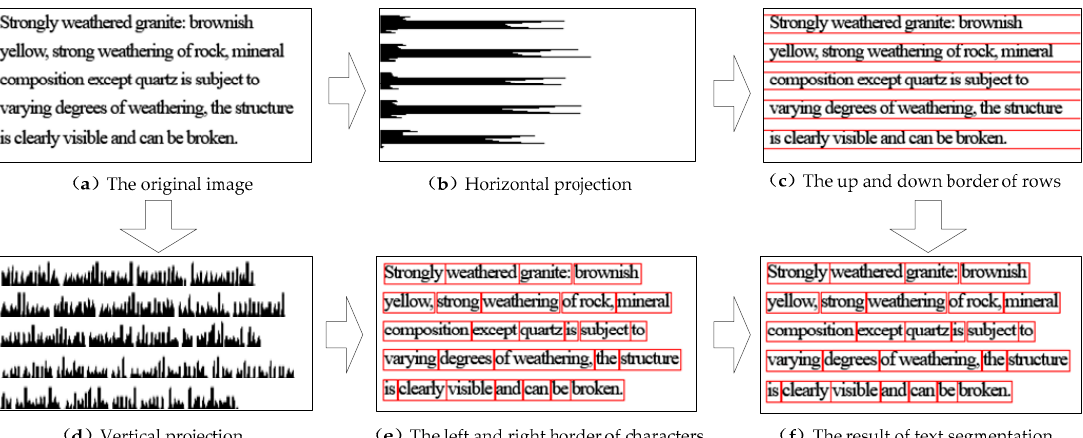
Figure 10. Process of text segmentation in cells.